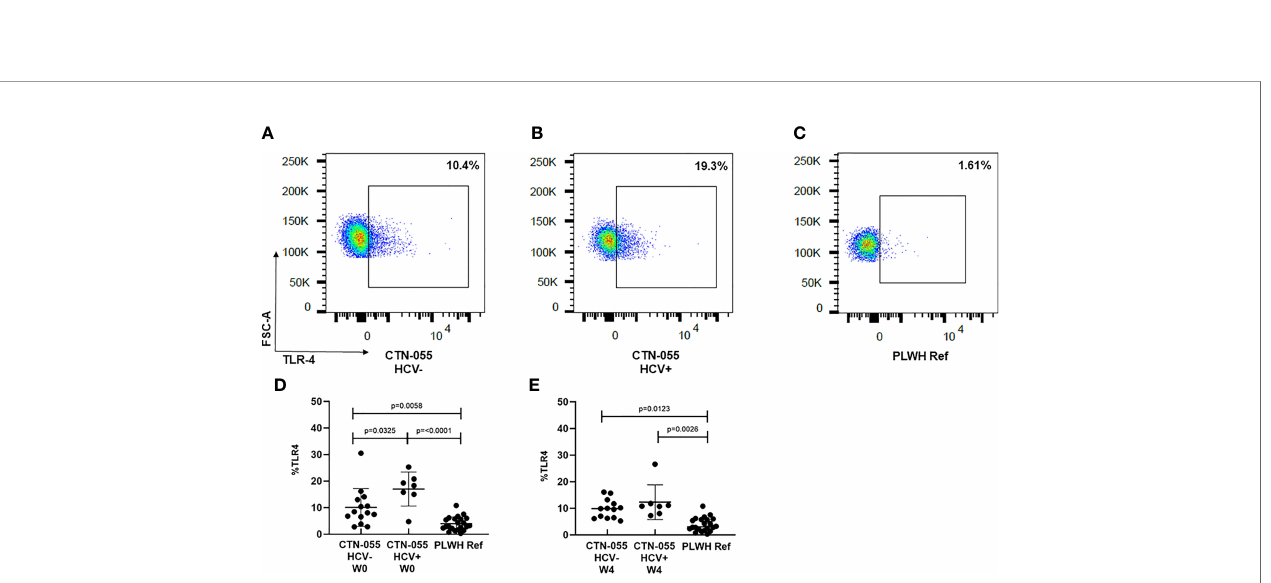
FIGURE 2 | Alcohol-use disorder Among PLWH is associated with increased monocyte TLR-4 cell-surface expression. TLR-4 expression was analyzed on the total CD14 + monocyte population using fl ow cytometry. Representative data are shown in CTN-055 HCV- (A) , HCV+ (B) and PLWH reference participants (C) . Means with SD of total CD14+TLR-4+ monocytes from all participants are shown at W0 ( D ; n = 21) and W4 ( E ; n = 20), and PLWH ref. population (n = 22) at study